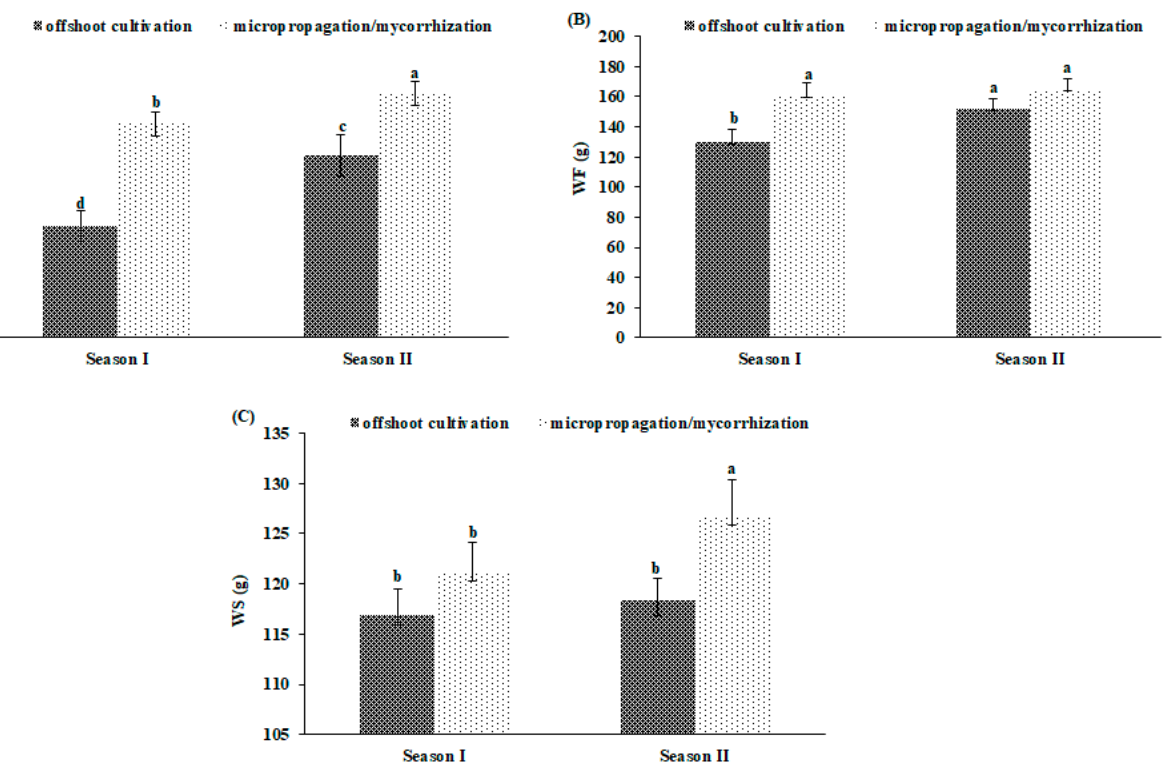
Figure 5. Bio-agronomical traits in clone of globe artichoke plants as affected by ‘propagation method × season’. Different letters indicate significance at Fisher’s protected LSD (least significant difference) test ( p ≤ 0.05). Vertical bars indicate ± standard deviation. NH, number of heads ( A ); WF,